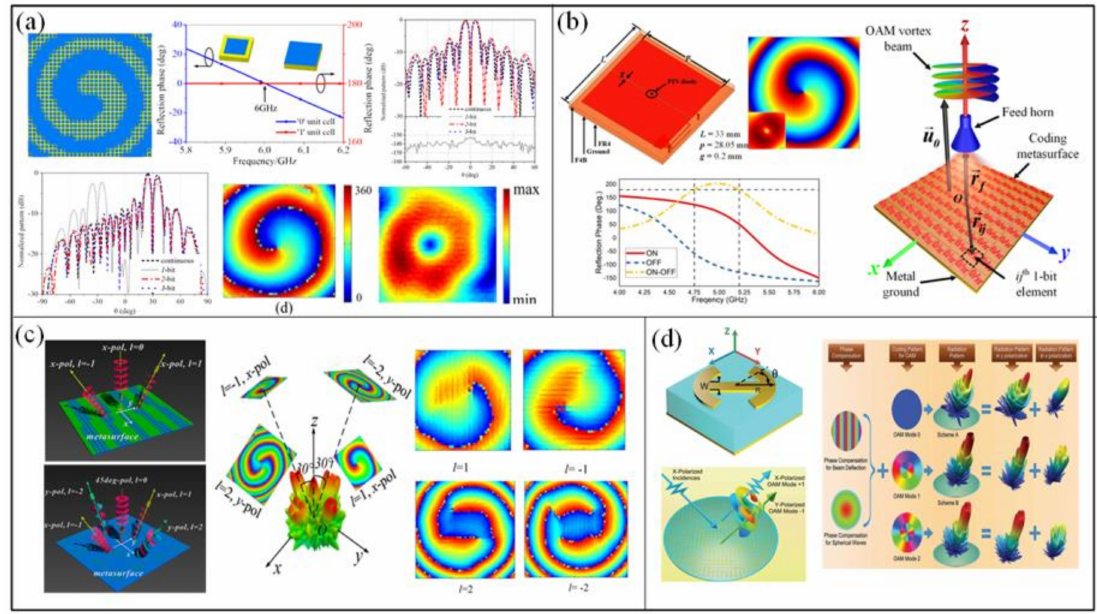
Figure 10. Digital coding OAM reflective metasurface. ( a ) One-bit passive OAM metasurface [61]. ( b ) One-bit active OAM metasurface [62]. ( c ) One-bit dual polarization OAM metasurface [63]. ( d ) Five-bit multi-polarization OAM metasurface